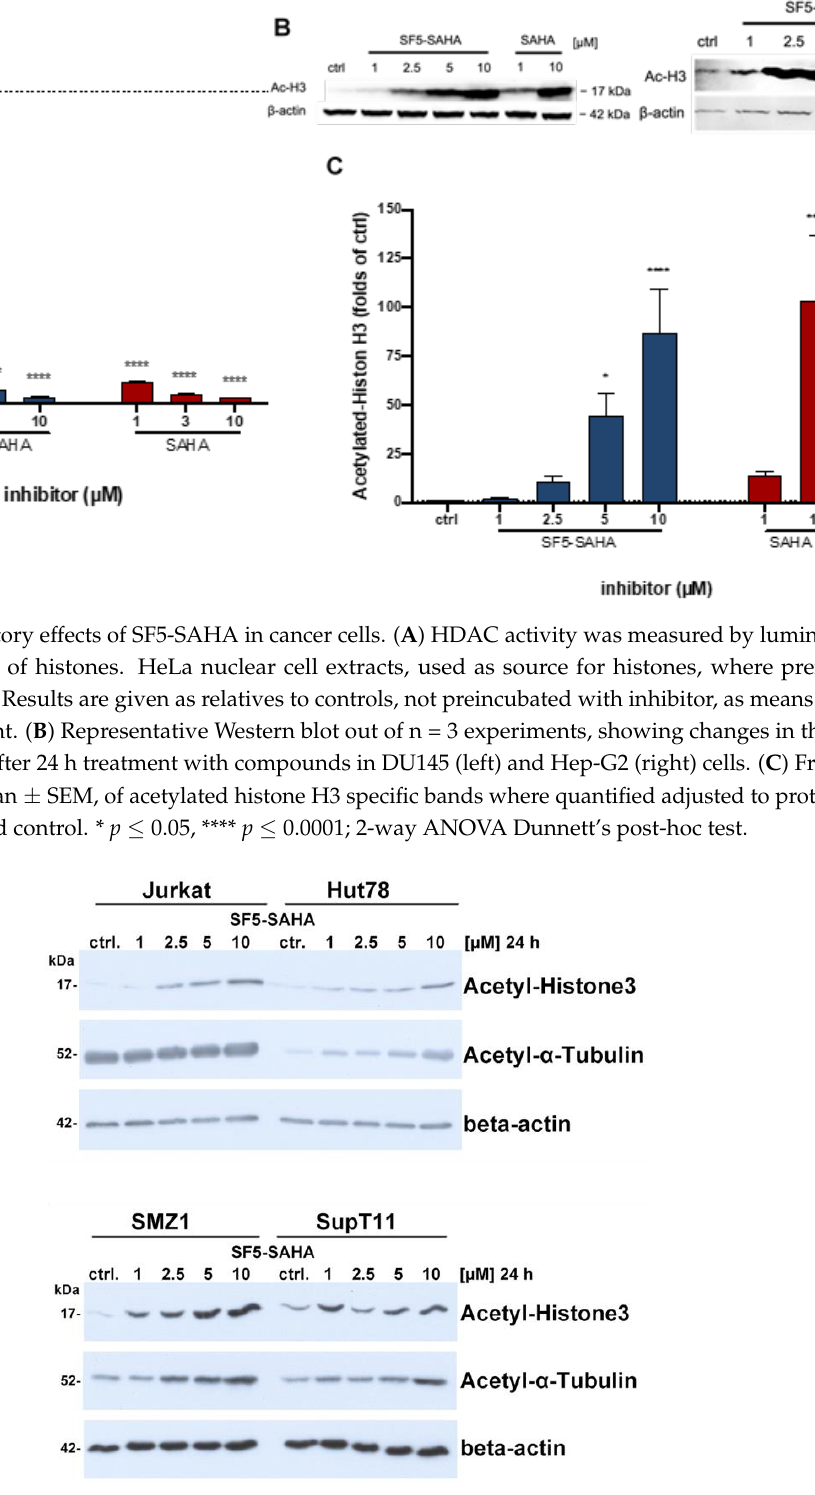
Figure 6. HDAC inhibitory effects of SF5-SAHA in T-cell leukemia/lymphoma cells (Jurkat, Hut78, SMZ1, SupT11). Representative Western blots out of n = 3 experiments, showing changes in the expression of acetylated histone H3 and acetylated α -tubulin after 24 h treatment with SF5-SAHA.